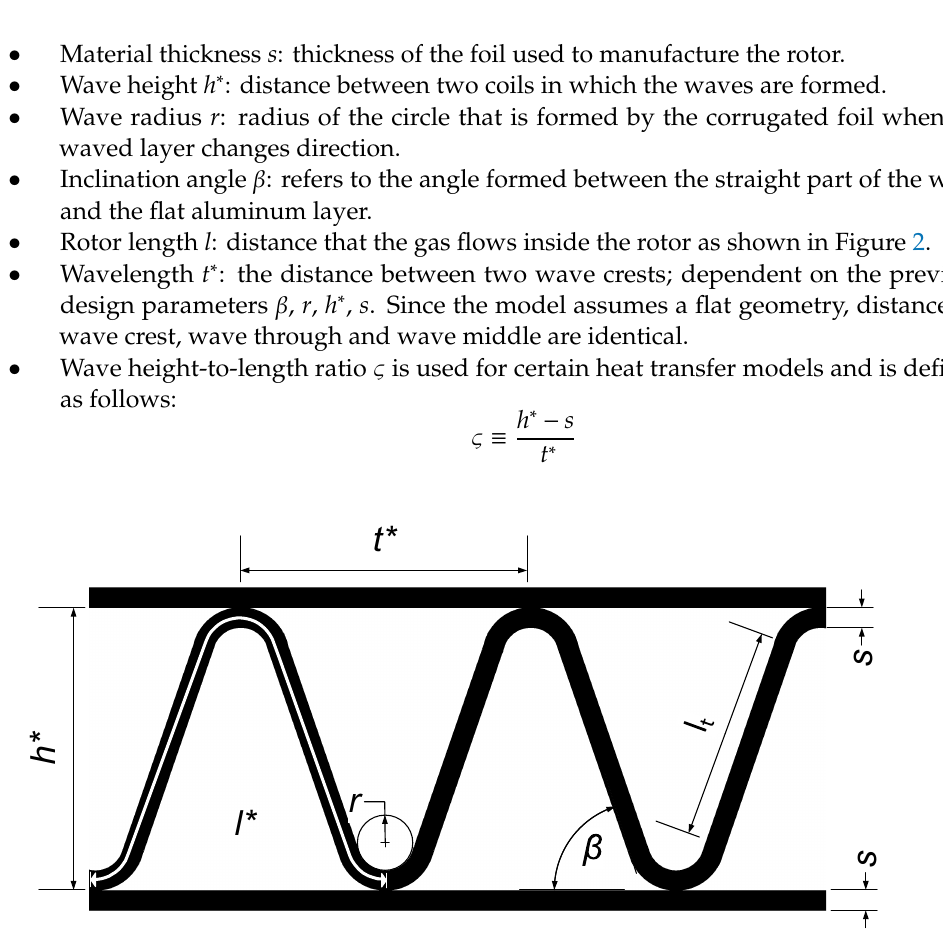
Figure 4. Design parameters (axial view). Note: l ∗ is shown in white within the wave. Using the parameters described, the length of a waved duct l